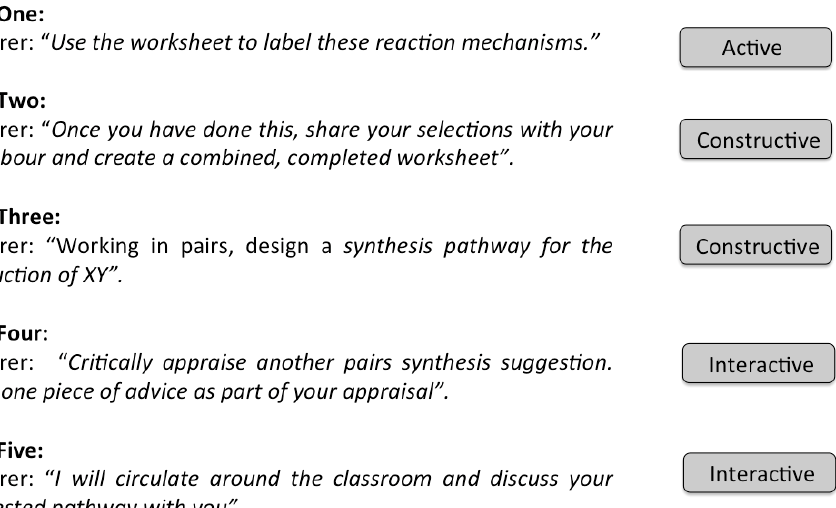
Figure 1: An example of a modelled hierarchical teaching philosophy to progressively promote a learning event from an active approach, through constructive, to an interactive approach. This modelled example is based on a typical first year foundation organic chemistry topic; organic reaction mechanisms and synthesis.